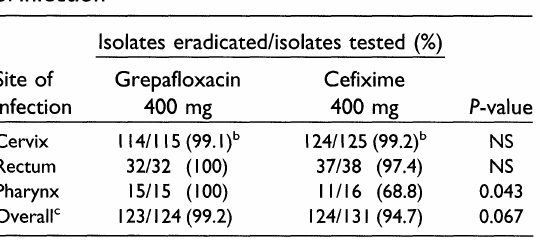
TABLE I. Eradication of N. gonorrhoeae by site of